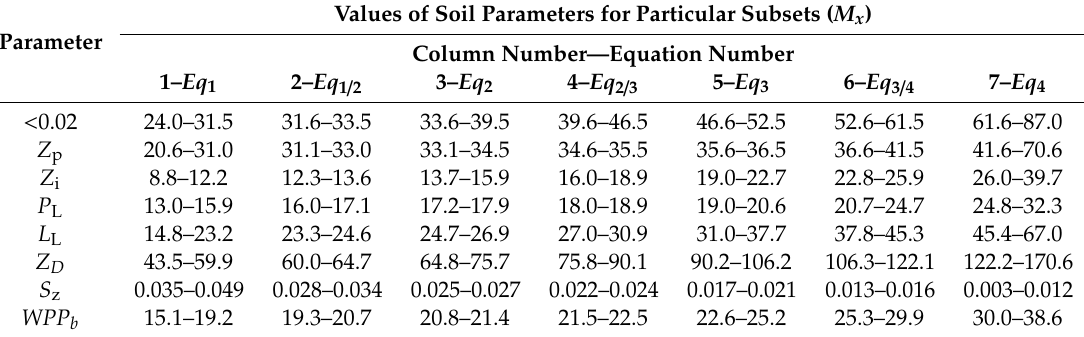
Table 8. A ffi liation criteria for particular series of Eq x ’ equations (Table 7) for cases from the verification set—median values of selected soil parameters for particular subsets ( M x ) of basic set. Values of Soil Parameters for Particular Subsets ( M x